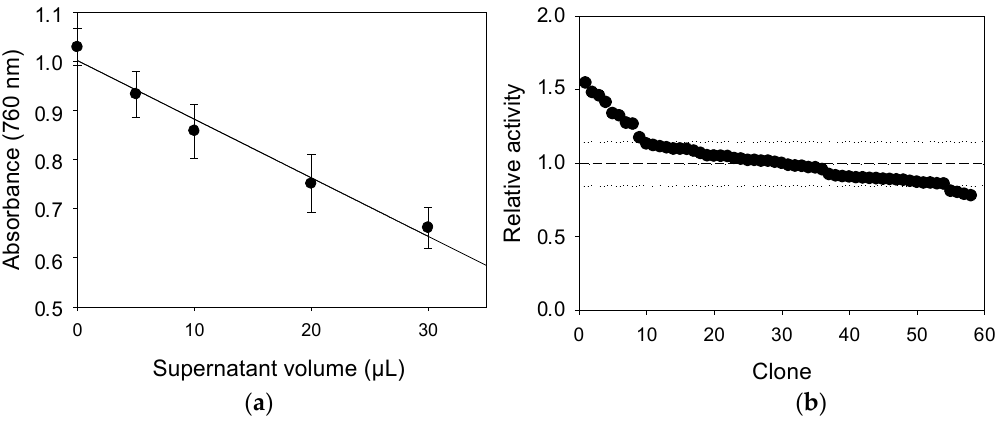
Figure 6. Linearity of the high throughput screening (HTS) colorimetric assay with increasing volumes of supernatant from S. cerevisiae microcultures secreting LAC4 ( a ); reproducibility of the assay shown by the relative activities of 60 replicas of S. cerevisiae clones secreting LAC4 (dotted lines indicate CV) ( b ).